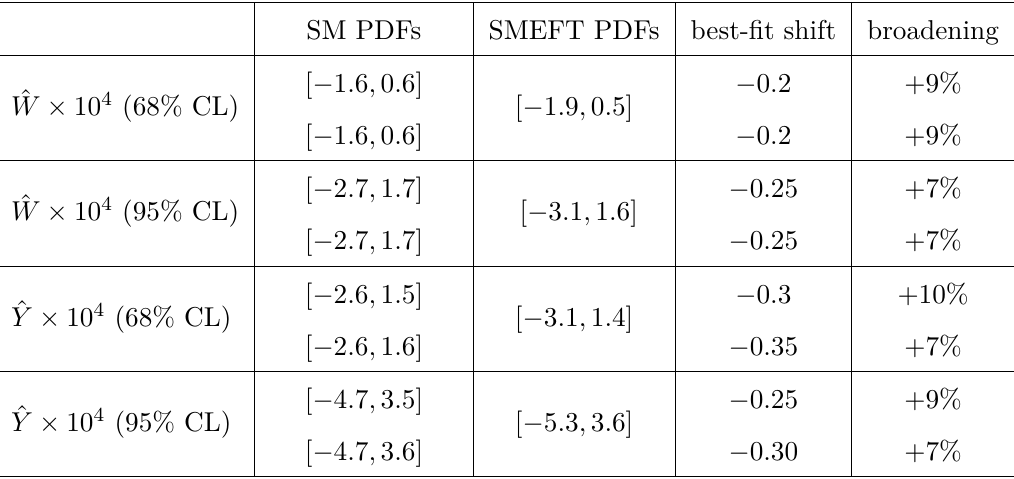
Figure 10 . Comparison between the results of the parabolic fits to the ATLAS search data [139] for ˆ W (left) and ˆ Y (right panel) when using the SMEFT PDFs ( χ 2 baseline ( χ 2 ). The insets zoom on the region close to λ ( ˆ W ) , λ ( ˆ Y ) ’ 0 . smp